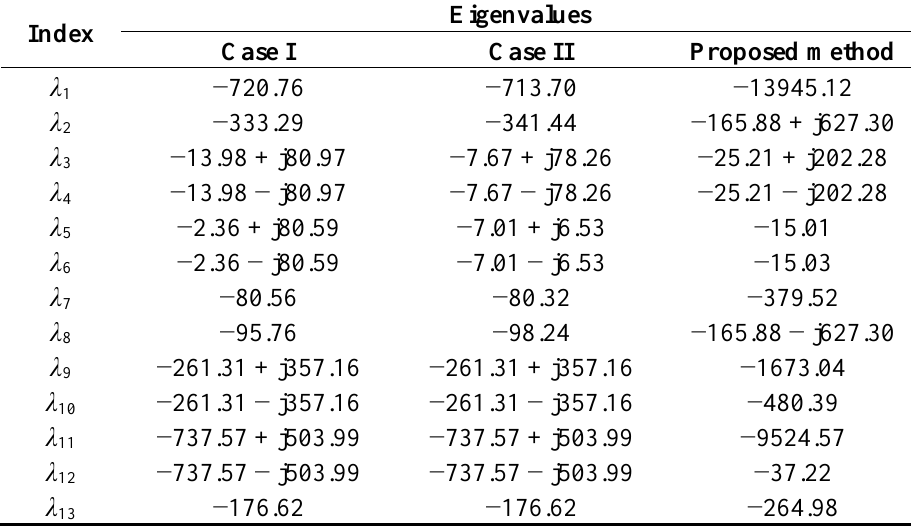
Table 2. Eigenvalues for three cases at v w0 = 8